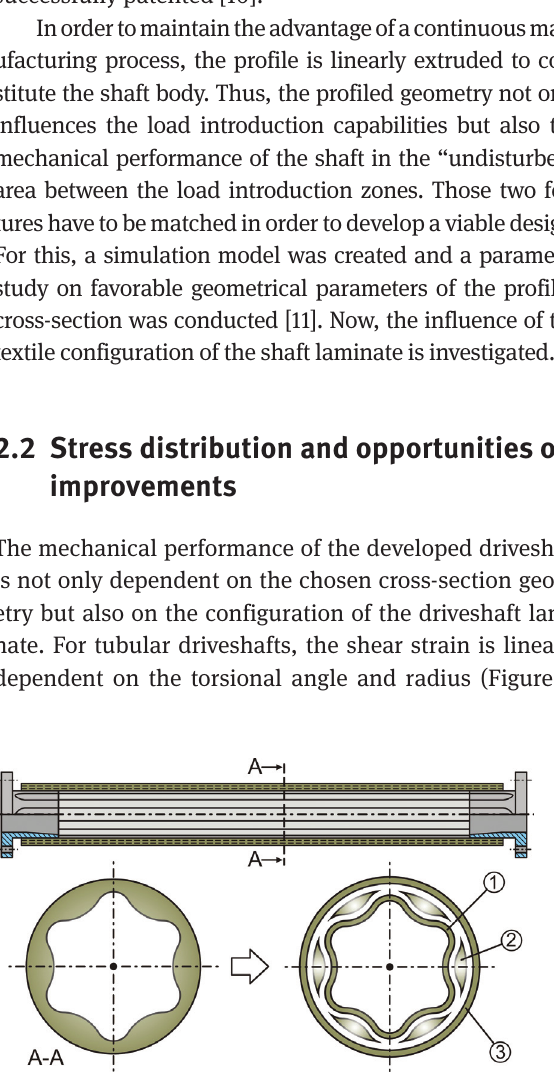
Figure 3 Novel driveshaft concept with modified cross-section consisting of a profiled shell (1), axial reinforcements (2), and cylin- drical shell (3).